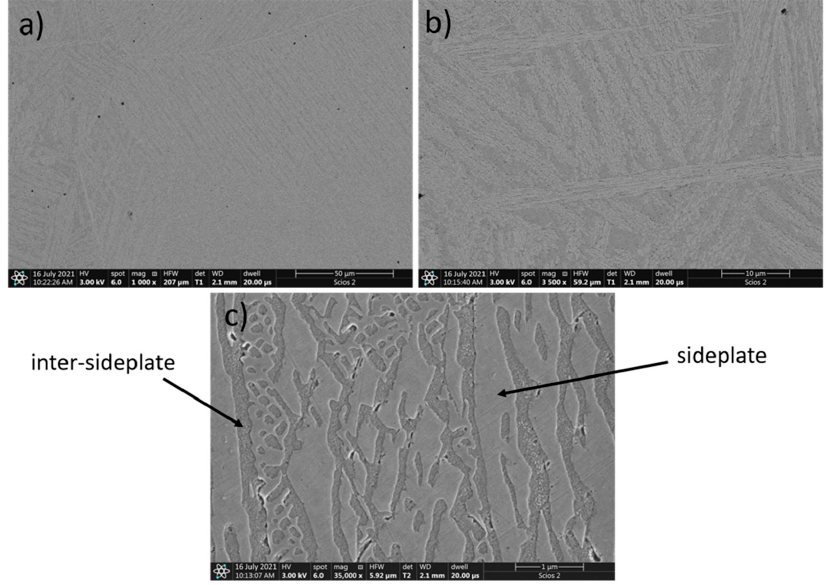
Figure 1. SEM images of Al 0.7 FeCrCoNi alloy, magnification: ( a ) 1000×, ( b ) 3500×, ( c ) 35,000×. Table 2. The chemical composition of Al 0.7 CoCrFeNi high-entropy alloy.